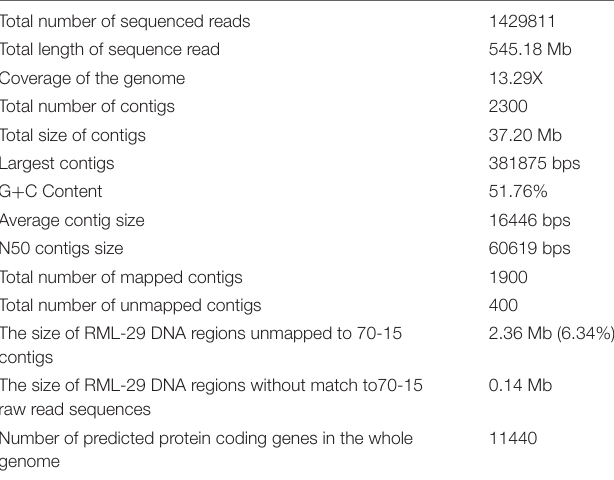
TABLE 1 | Structural features of M. oryzae isolate RML-29 whole genome